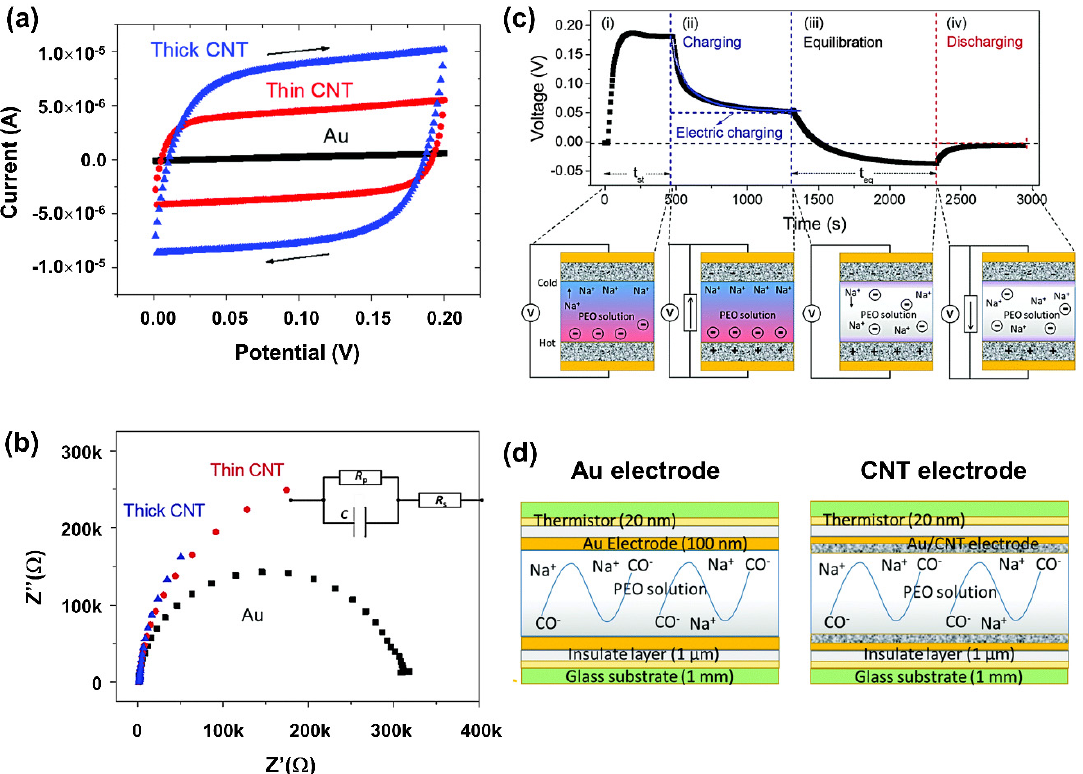
Figure 12. An SC’s self − charging demonstration utilized by the Soret effect: ( a ) CV curves from different types of electrodes in a square shape indicating the purely capacitive behavior of an electrode, with thick CNT results showing higher capacitance; ( b ) a Nyquist plot from impedance spectroscopy measurement of Au, thin CNT, and thick CNT electrodes, with equivalent circuit parameters the capacitance of thick CNT being higher; ( c ) a charge − discharge cycle of an Ionic Thermoelectric Supercapacitor (ITESC) establishing a temperature gradient of 16 K and discharging after the equilibration phase; and ( d ) a schematic illustration of the ionic thermoelectric supercapacitor device configuration with two different electrodes (right: Au and left: CNT) and with the reaction that takes place in the solution: reprinted from Reference [191]. Copyright. The Royal Society of Chemistry,